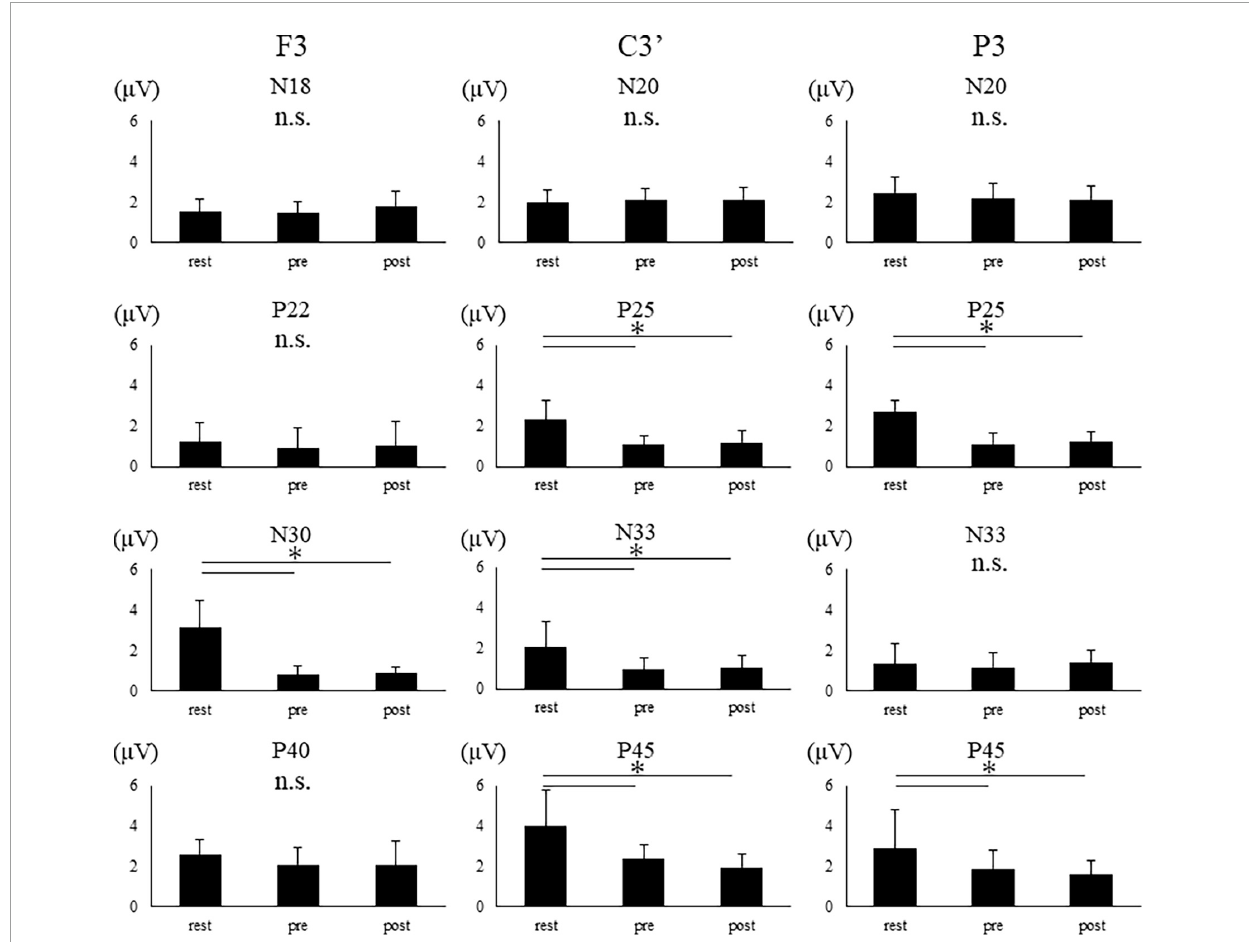
FIGURE6 SEP amplitudes of the two groups in each condition at each electrode site. The error bar indicates standard deviations. Asterisks indicate significant differences ( p <